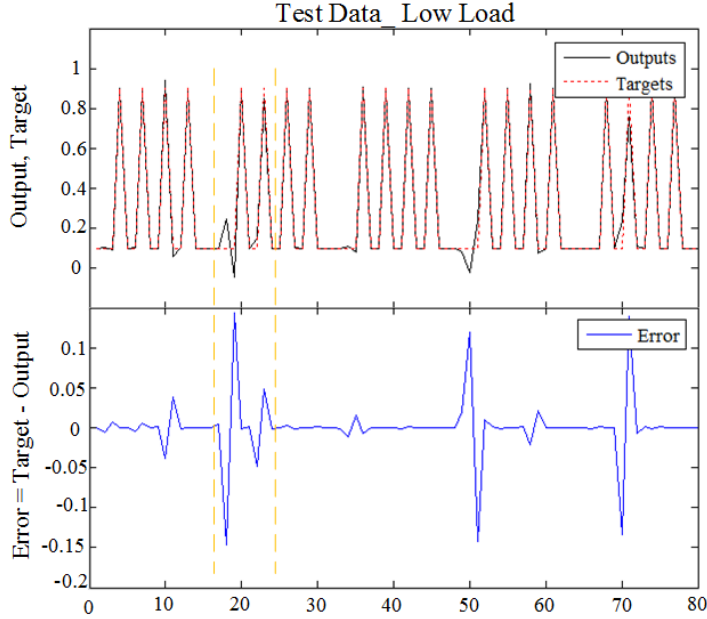
Figure 15. The Error between Real Output and Desired for Testing Data Set in 35% of Full Load.